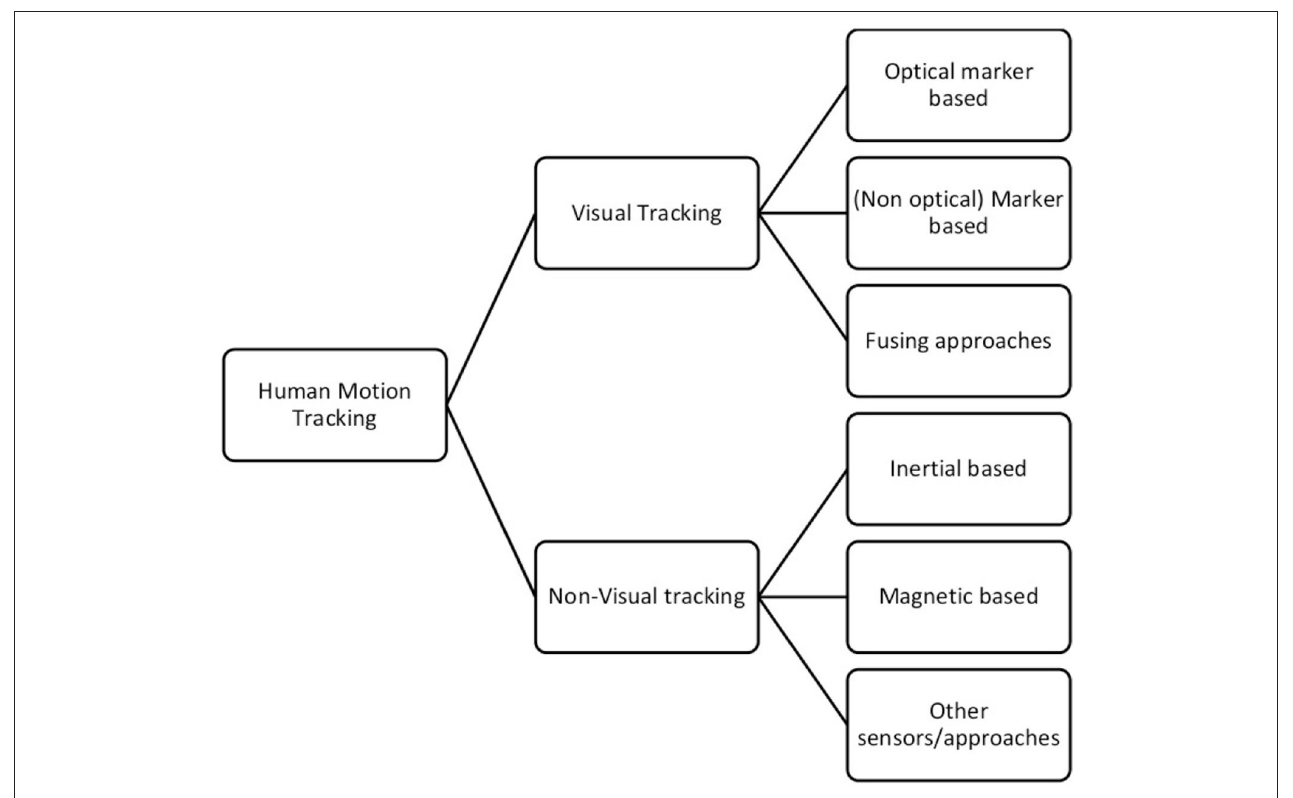
FIGURE 1 | Human motion tracking